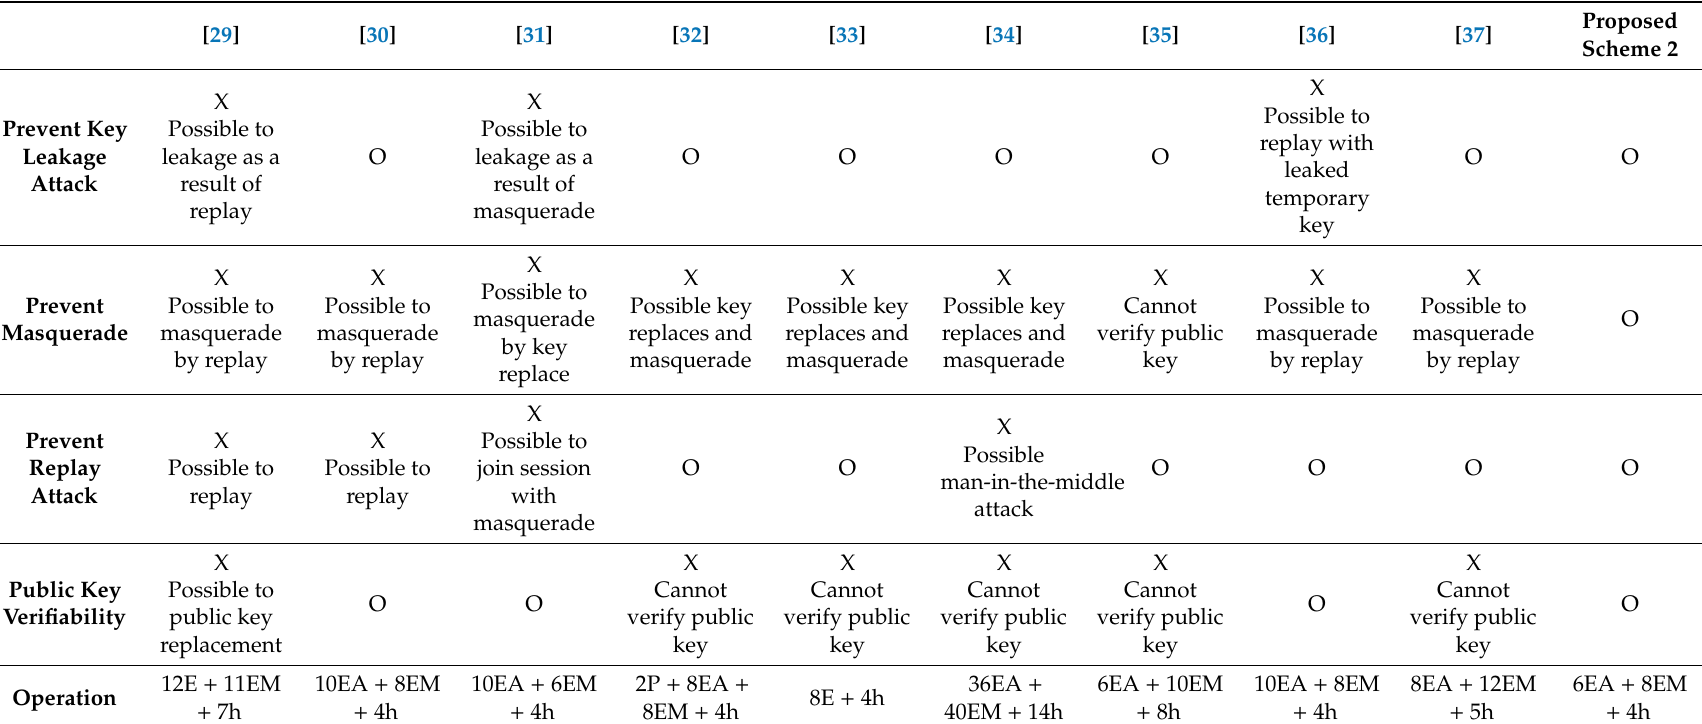
Table 4. Comparison of Scheme